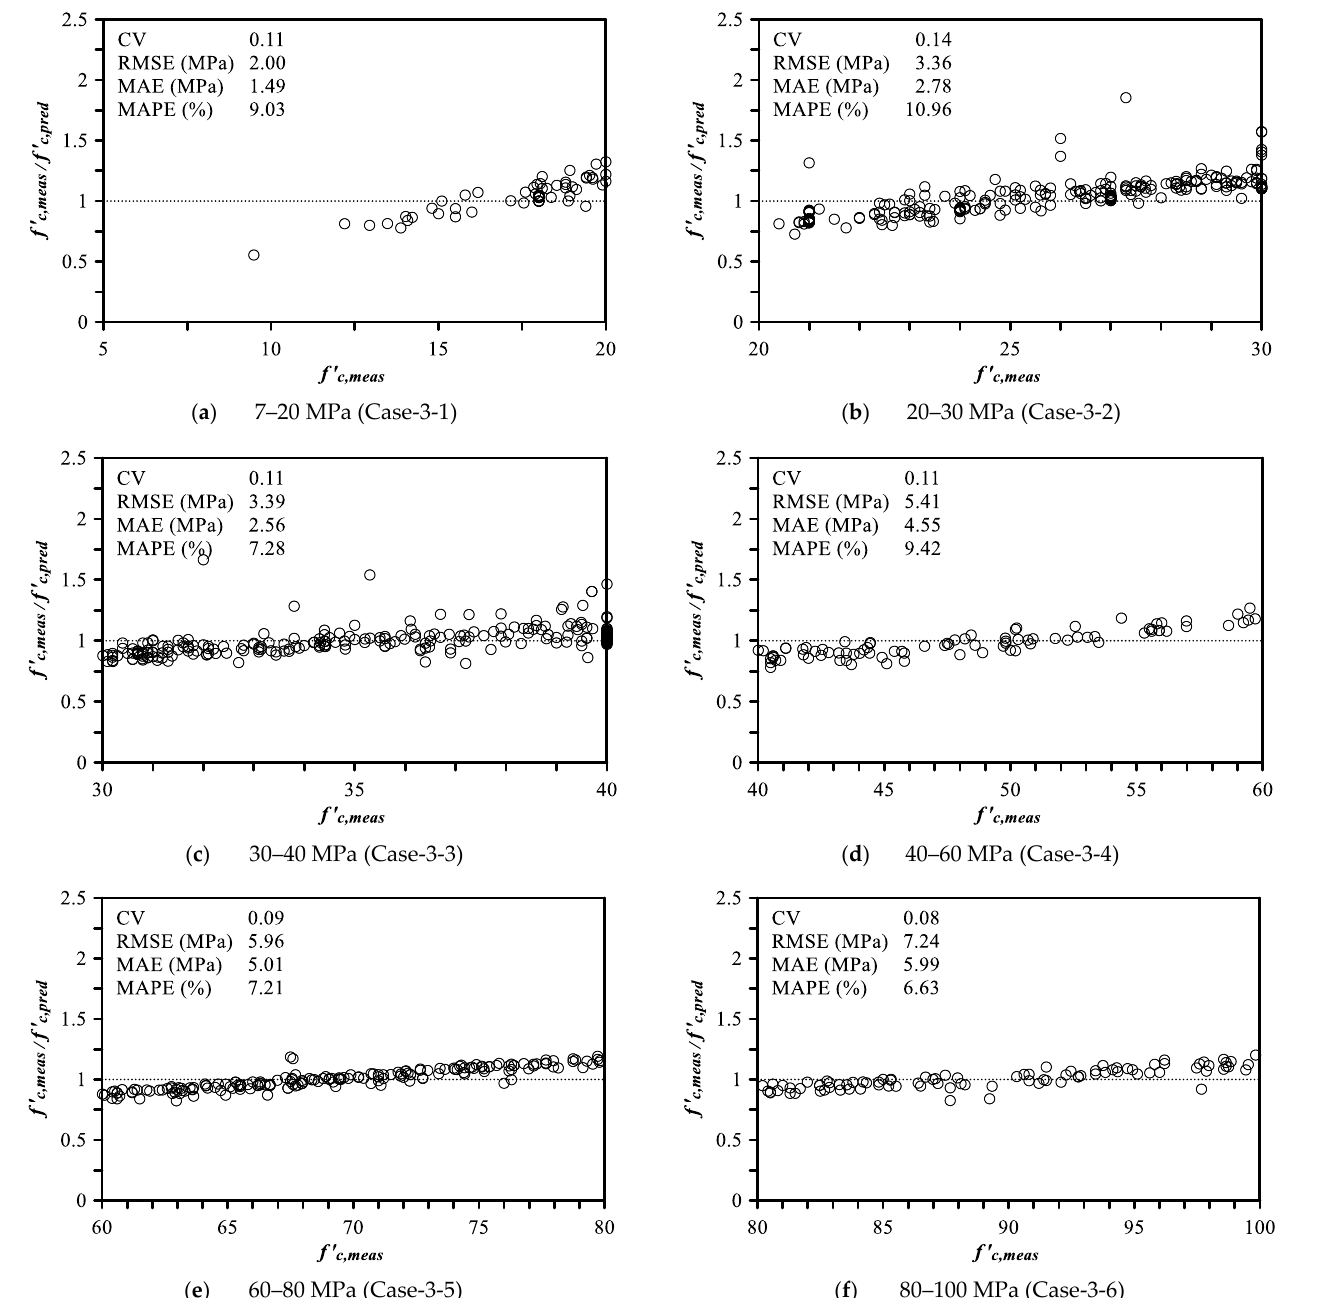
γ obtained from each subcase and f (cid:48) c , meas Figure 6. Relationship between  obtained from each subcase and f ’ c , meas . Figure 6. Relationship between